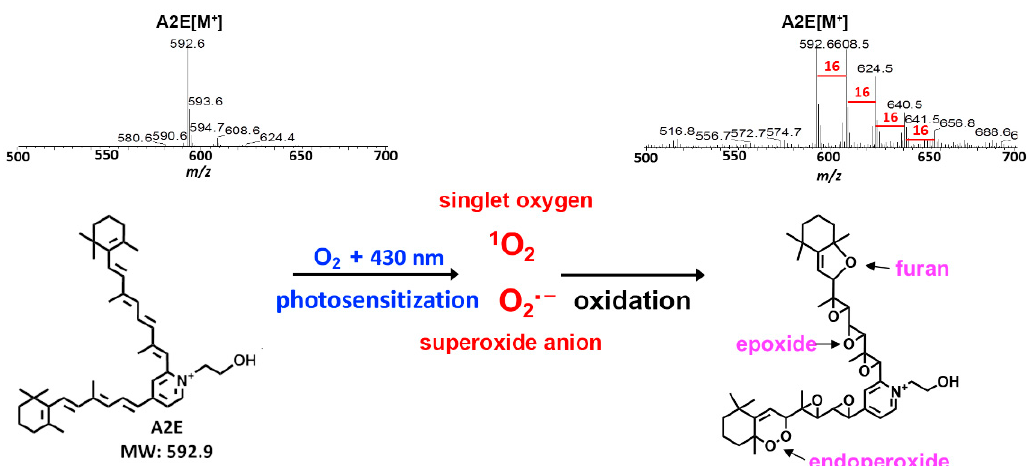
Figure 3. Photosensitization and photo-oxidation of bisretinoids illustrated using the bisretinoid fluorophore A2E as a model. The mass to charge ratio ( m/z ) of nonirradiated A2E is 592. Bisretinoids such as A2E initiate photosensitization reactions that generate singlet oxygen and superoxides. Singlet oxygen is inserted into double bonds along the side-arms of the molecule. The series of peaks from m / z 608 to 656 detected by electrospray ionization (ESI) mass spectroscopy indicate the addition of oxygen (mass 16), and reflect photo-oxidation at carbon–carbon double bonds. Proposed structures of the oxygen-containing modifications of A2E include furan, epoxide, and endoperoxide moieties.